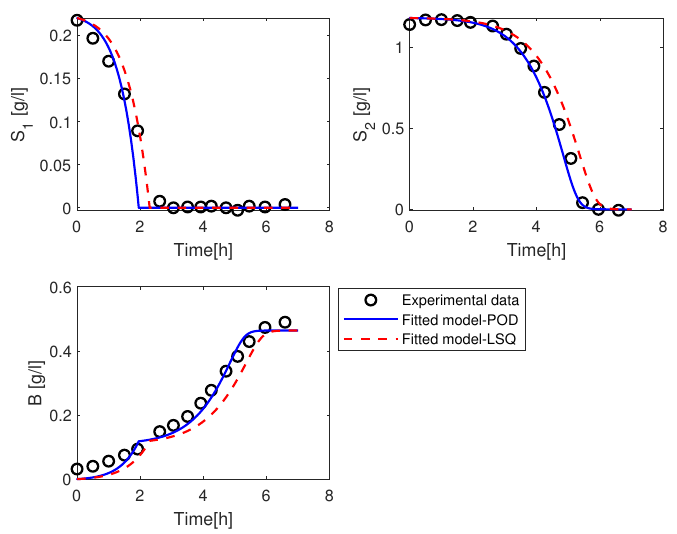
Figure 6. Simulation of the solution of the kinetic model with the parameters value k s 1 and k s 2 using POD method in blue (solid line), LSQ method in red (dashed line), and the experimental data in black (open